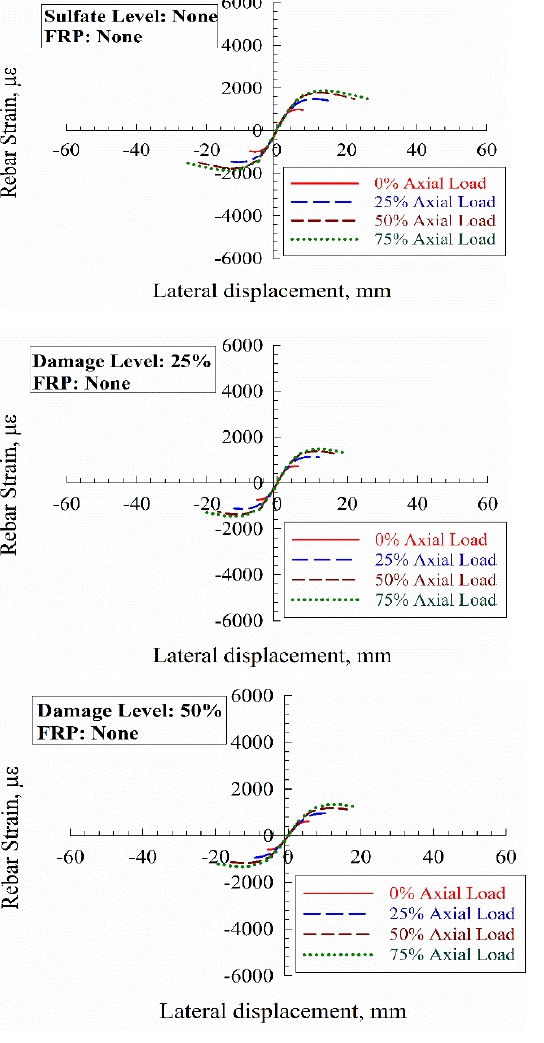
Figure 12. The beam’s reinforcement steel strains.